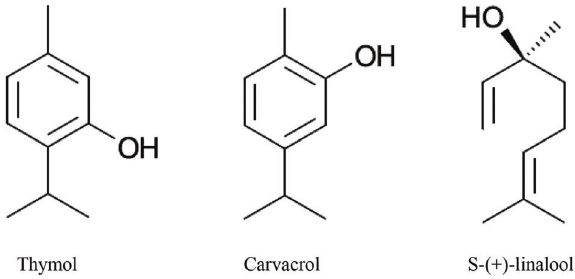
Figure 1. Chemical structures of the evaluated